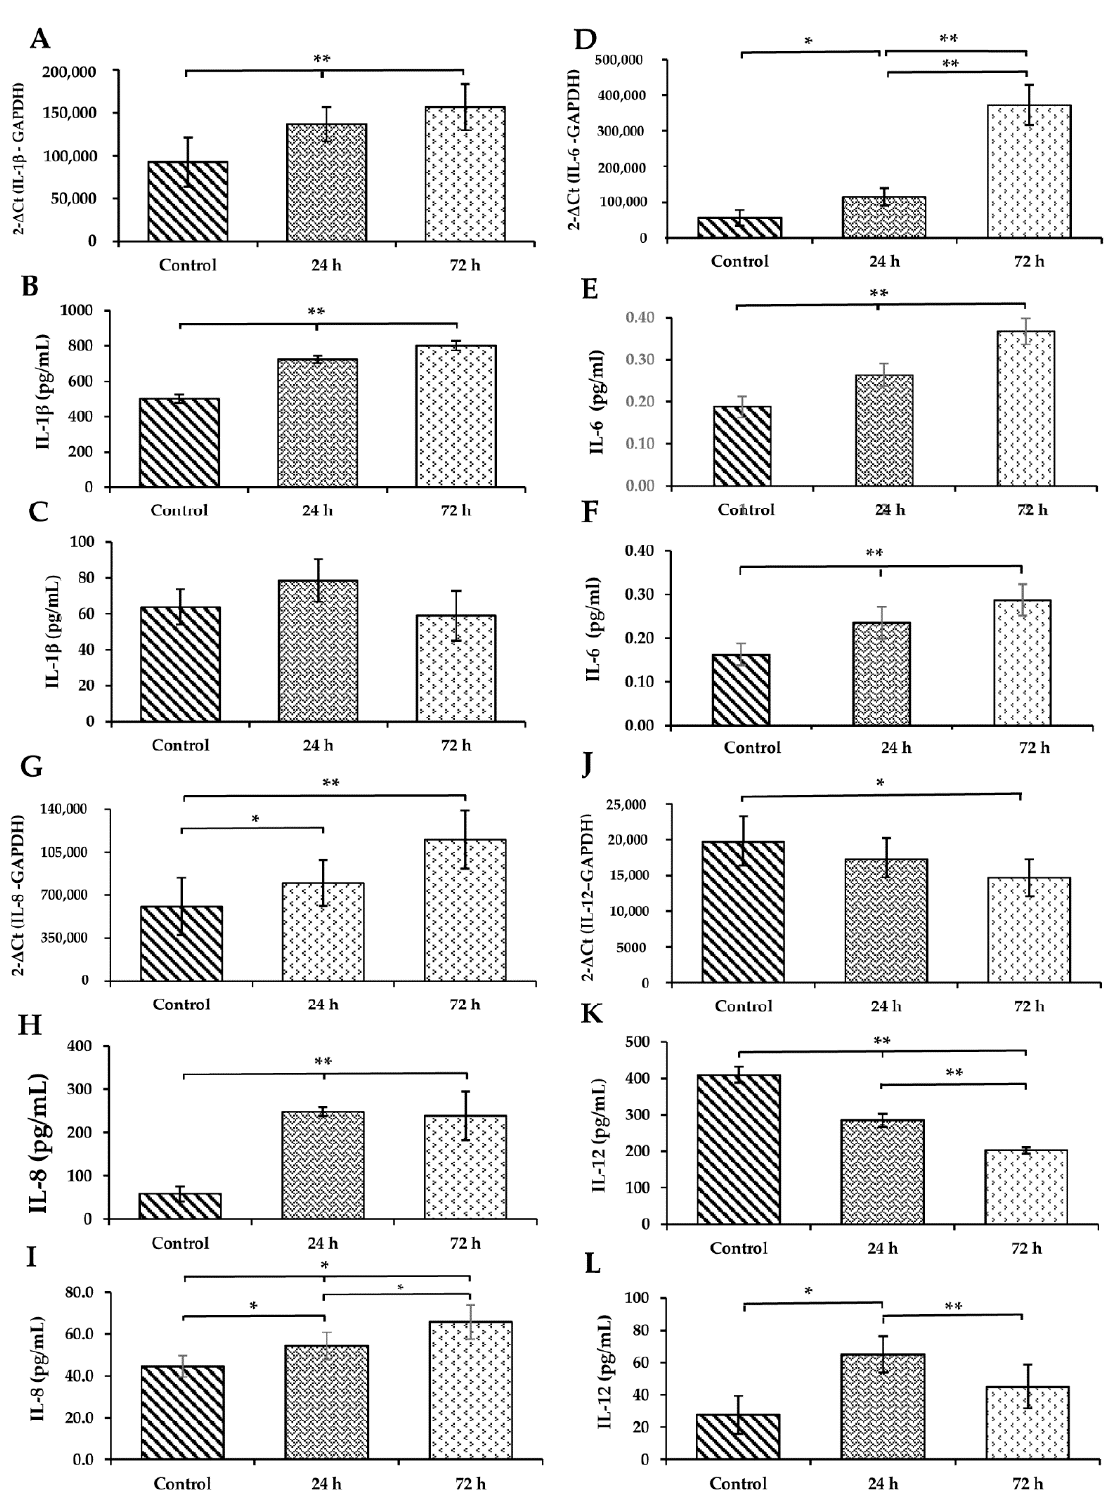
Figure 3. Effect of short-term WS in mRNA expression levels of IL-1 β ( A ), IL-6 ( D ), IL-8 ( G ), IL-12 ( J ) in the lung, and protein concentration of IL-1 β in BAL ( B ) and serum ( C ), IL-6 in BAL ( E ) and serum ( F ), IL-8 in BAL ( H ) and serum ( I ), and IL-12 in BAL ( K ) and serum ( L ). qRT-PCR was used to detect the mRNA levels of expression, and ELISA was employed to detect the protein levels in BAL and serum ( n = 8). Statistical analyses were one-way analysis of variance (ANOVA), followed by Tukey–Kramer post hoc test. * p < 0.05; ** p < 0.01 compared with the control.